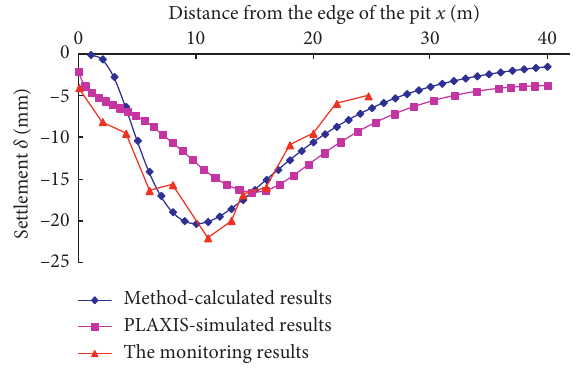
Figure 11: Surface settlement.